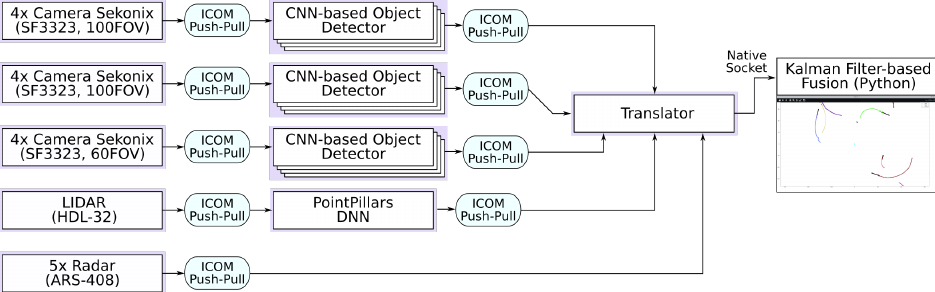
Figure 9. Object detection and mapping subsystem of the EDI DbW car.